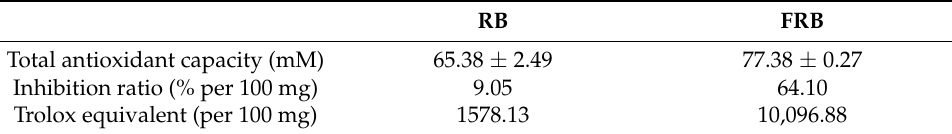
Table 1. Antioxidant ability of the water extract of fermented rice bran (RB; FRB). RB FRB Total antioxidant capacity (mM)